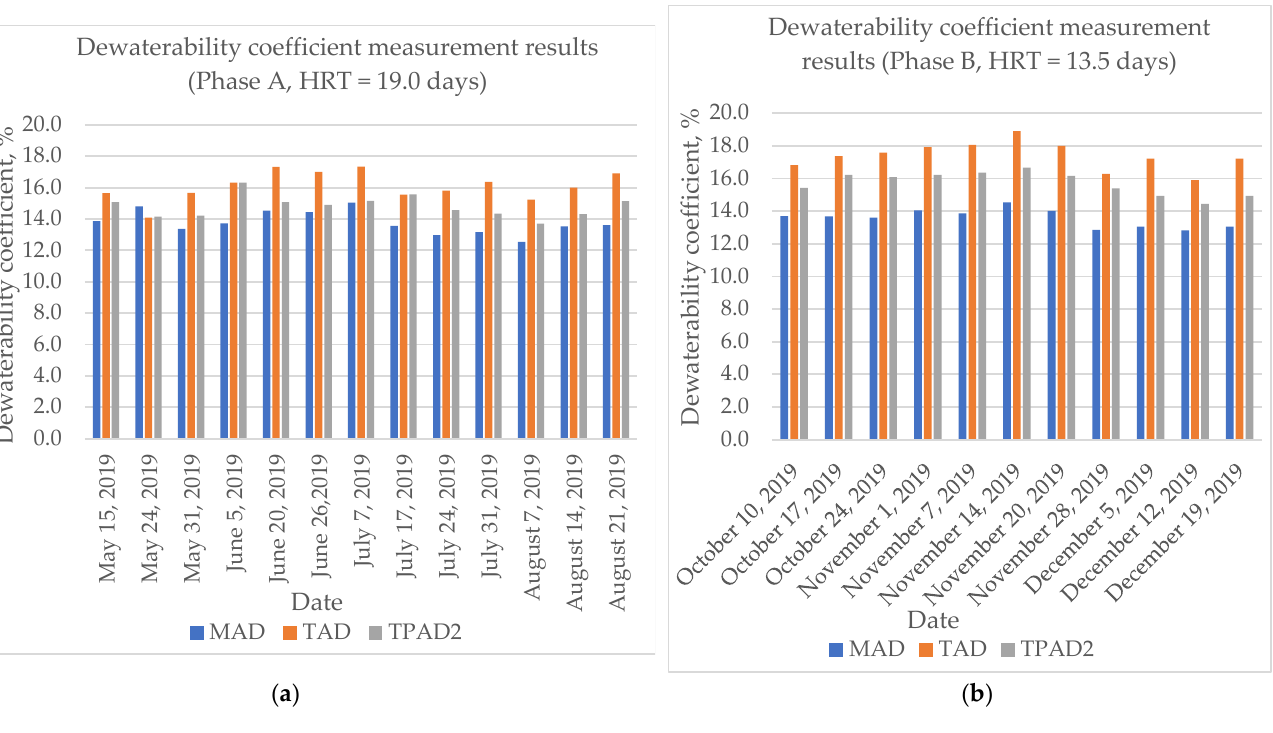
Figure 4. Dewaterability coefficient at Phase A ( a ) and at Phase B ( b ).